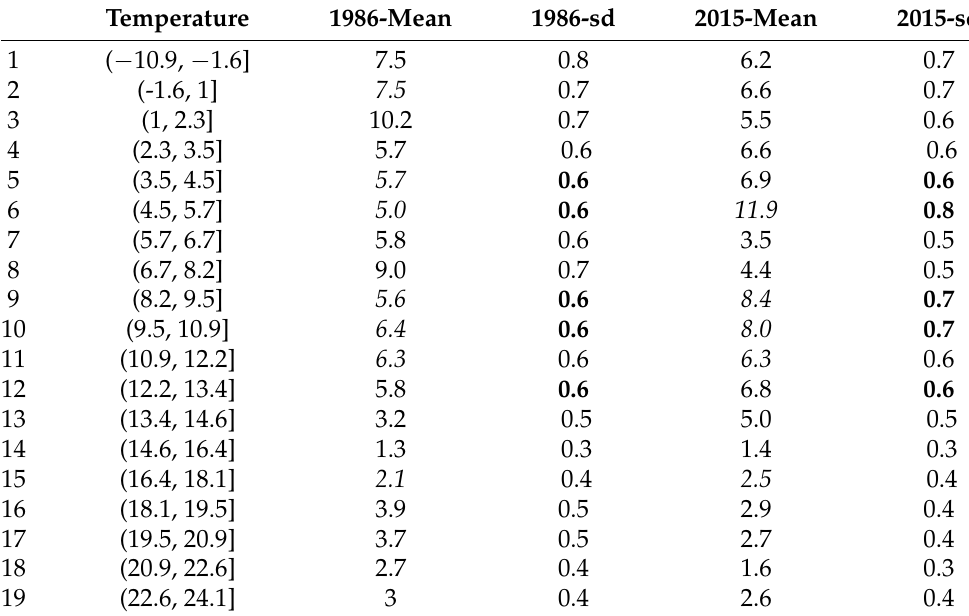
Table 5. Data Simulated: Mean and standard deviation of 1000 meteorological bootstrapped observa- tions of Lombardy for temperature classes in 1986 and 2015. The mean values highlighted in italics are slightly different from the original table. The standard deviations (sd) highlighted in bold are those of the critical temperature